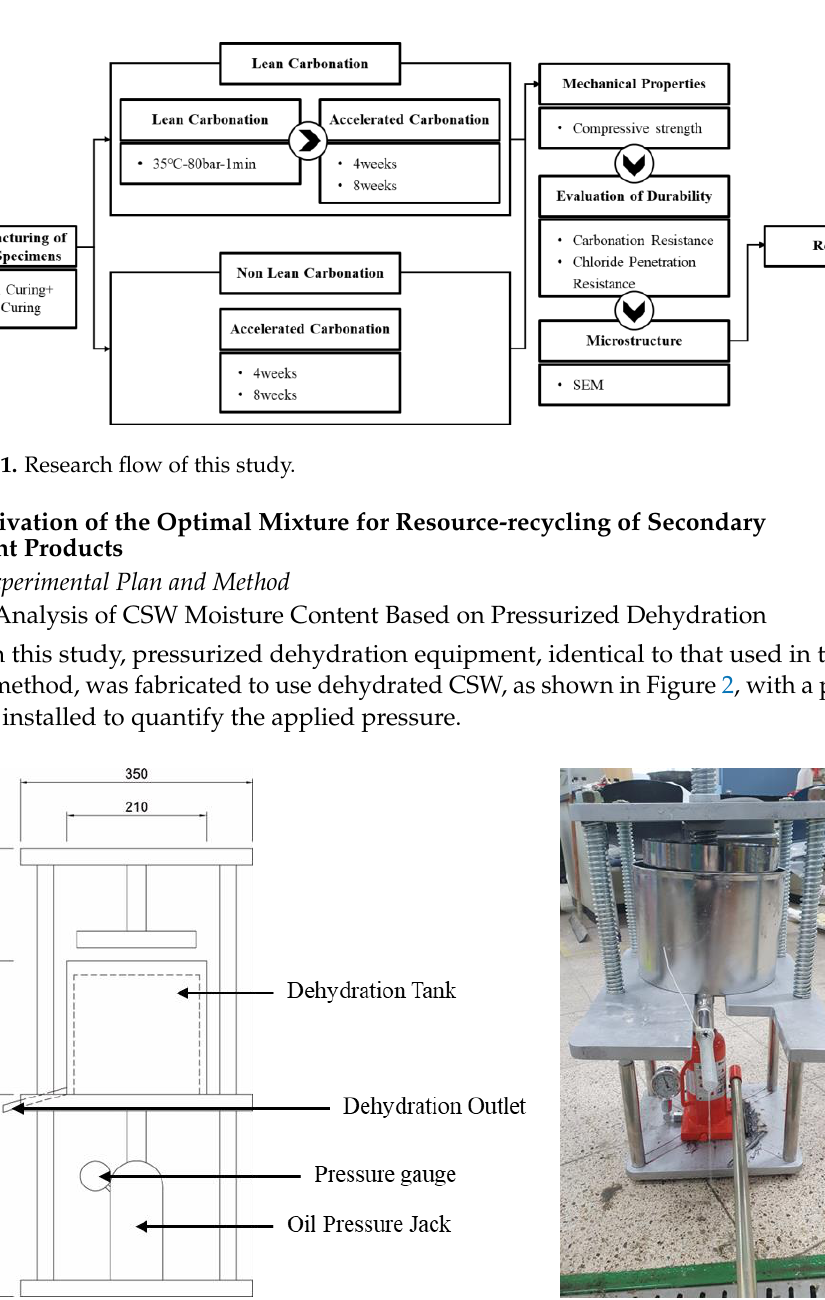
Figure 2. Pressurized dehydration equipment: ( a ) conceptual diagram and ( b ) installation example.